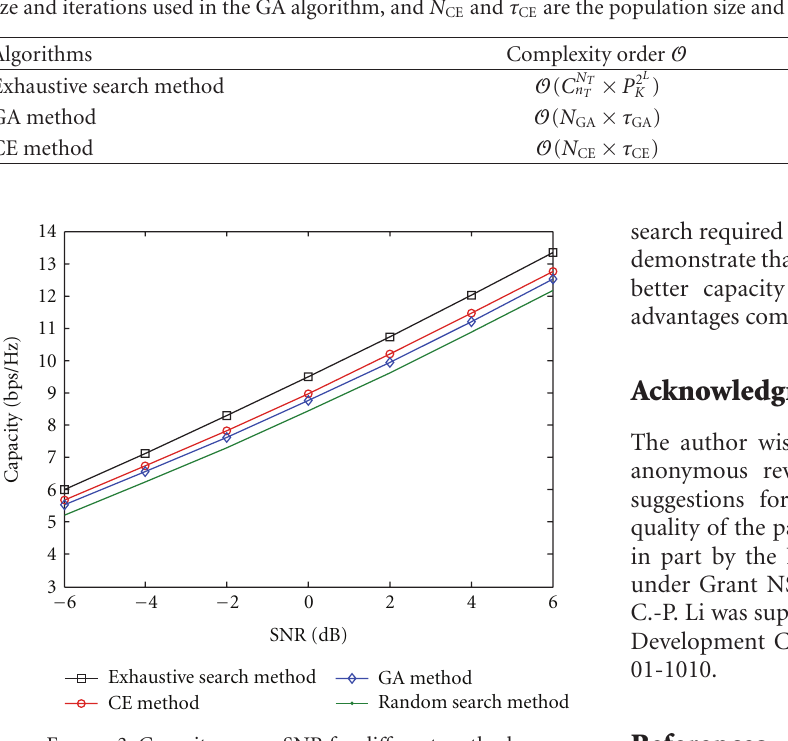
τ GA and GA are the population